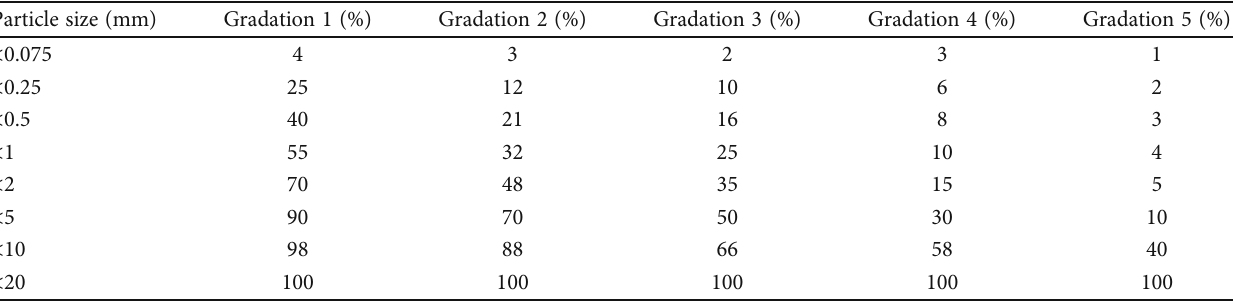
Table 3: Particle size distribution of di ff erent gradations.